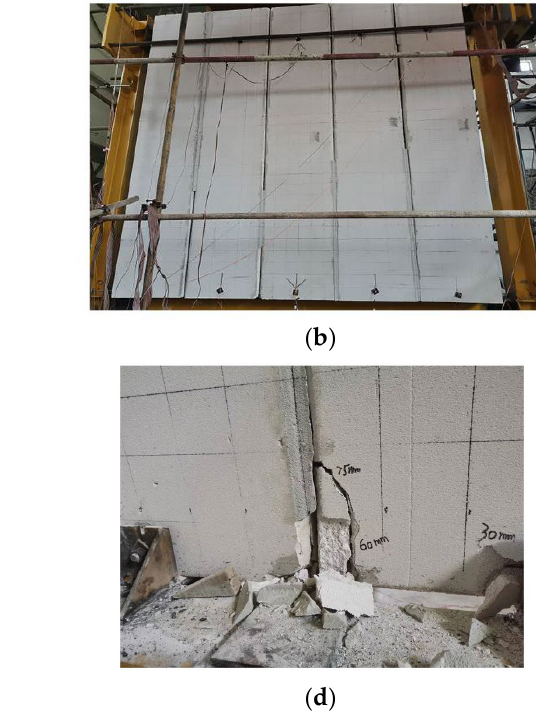
Figure 13. Collaborative mechanism of ALC panels and steel frame. ( a ) No earthquake effect. ( b ) Light and medium earthquakes. ( c ) Relative dislocation of ALC panels. ( d ) ALC panels cracking.